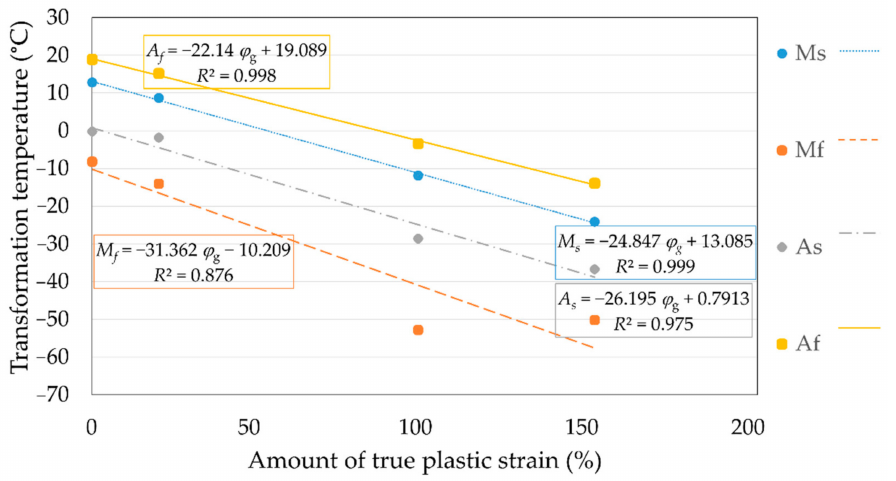
Figure 9. Transformation temperatures vs. true plastic strain of ausforming-treated